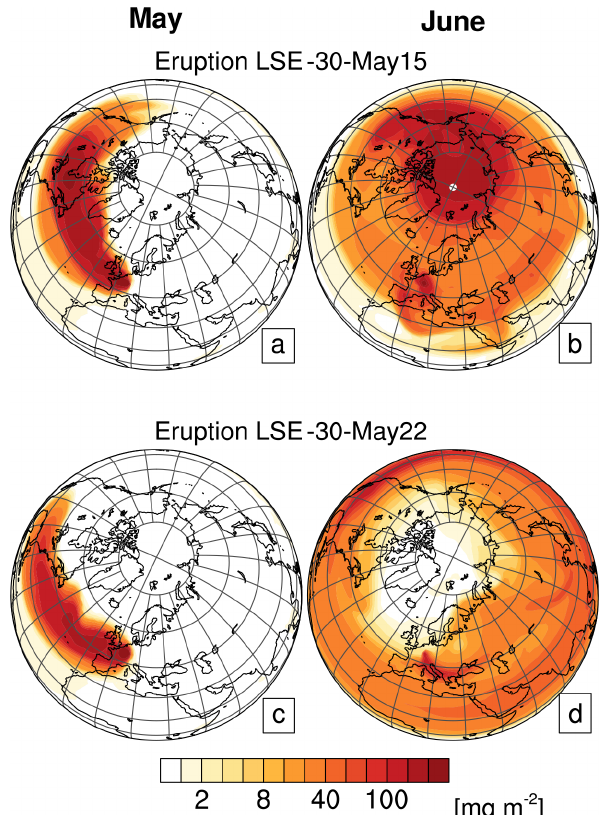
Figure 9. Monthly mean sulfur burden (SO 2 plus sulfate) shortly after the eruption (May, a , c ; June, b , d ) for the LSE-30-May15 (a, b ) and LSE-30-May22 (c, d) scenarios with the same eruption rate but eruption on 15 and 22